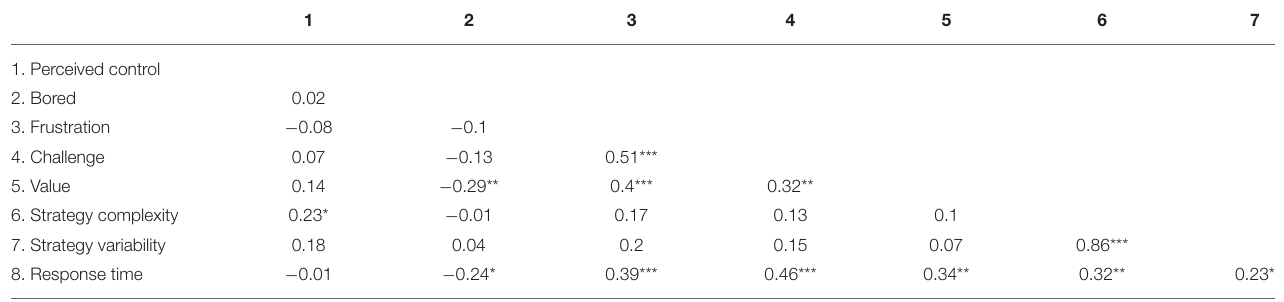
TABLE 5A | Zero-order correlations of all study variables and their significance levels (Study 2). 1 2 3 4